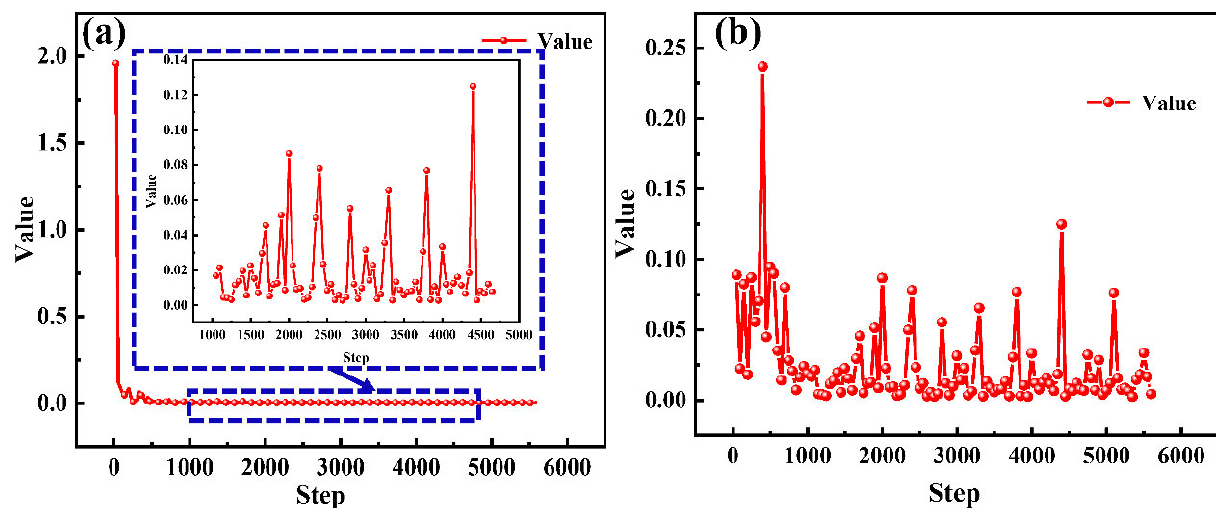
Figure 9. Comparison of loss during ANN: ( a ) training and ( b ) verification.